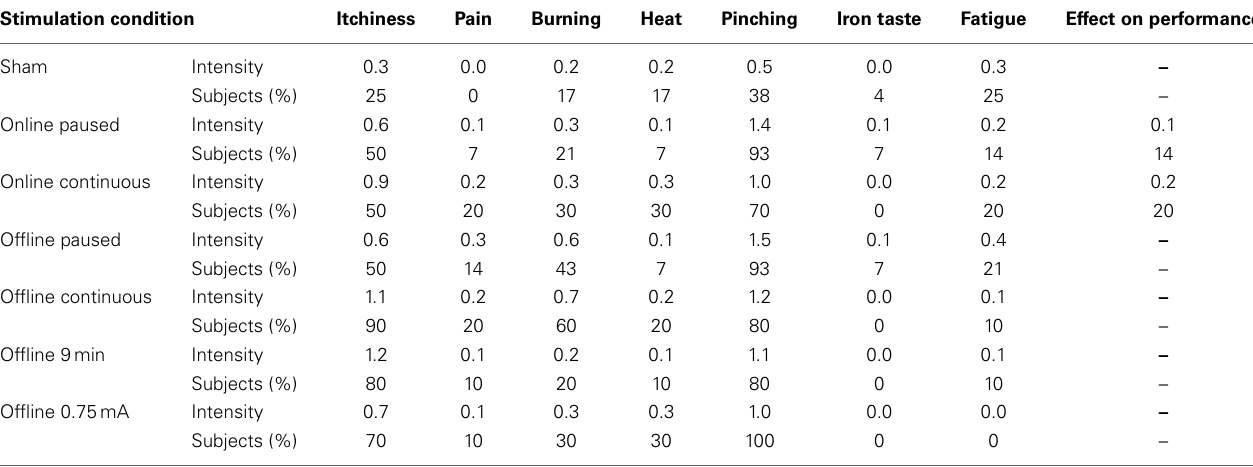
Table 1 | Transcranial direct current stimulation (tDCS)-induced sensations—Experiments 1 and 2: mean intensity of the sensations reported by subjects after tDCS and the percentage of subjects who reported each